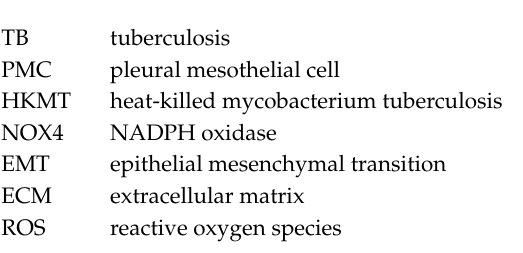
Figure S1: TLR4 inhibition and AT1 inhibition improve impaired autophagy caused by HKMT treatment. Figure S2: NADPH oxidase 4 (NOX4) levels in pleural effusion of adults with tuberculous pleurisy and